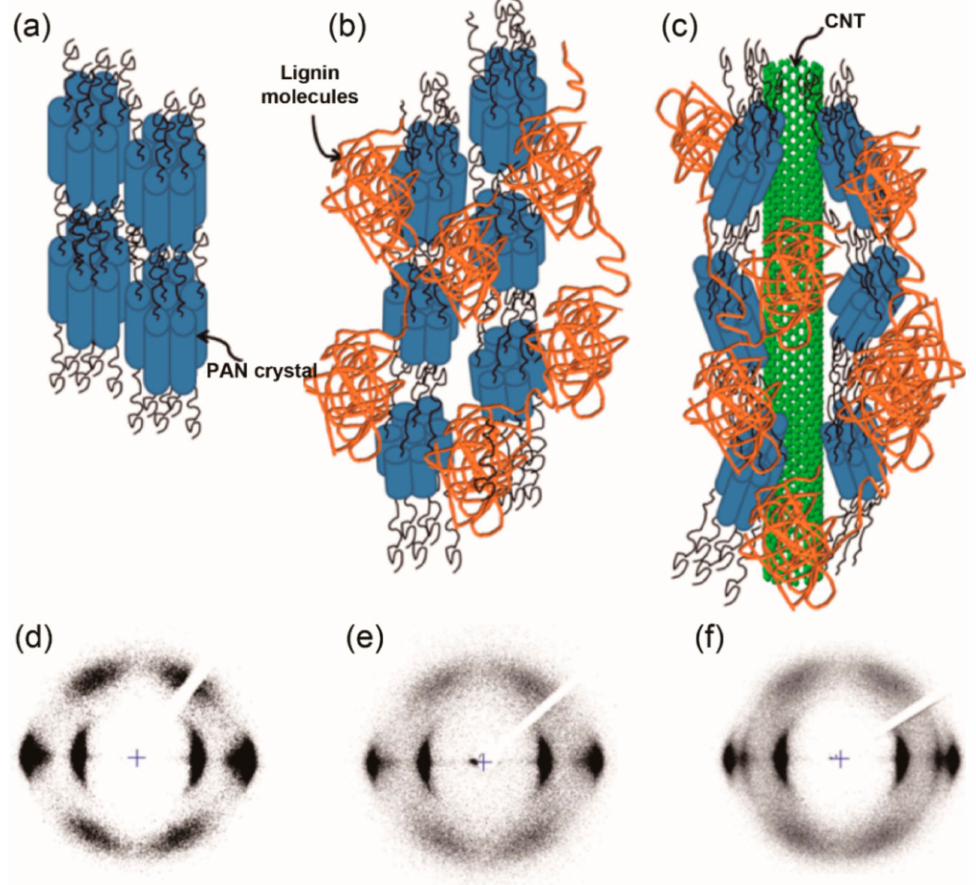
Figure 9. Schematics of gel-spun fibers of ( a ) PAN, ( b ) lignin/PAN, and ( c ) lignin/CNT/PAN fibers. Wide-angle X-ray diffraction (WAXD) patterns of precursor fibers (draw ratio of 13) of ( d ) PAN, ( e ) lignin/PAN, and ( f ) lignin/CNT/PAN fibers. ( a – f ) Reproduced with permission from [123], copyright 2015 American Chemical